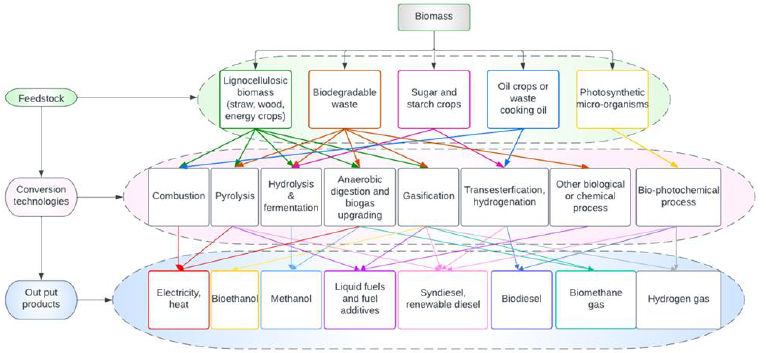
Figure 1. Basic biomass energy feedstocks, conversion technologies, and output products, adopted from [8,16 – 23]. Rice ( Oryza sativa L.) has been a staple food in Sri Lanka since ancient times; the rice consumption per capita was close to 107 kg in 2019, according to the Sri Lanka Rice Re- search Center. The two main seasons for paddy harvesting in Sri Lanka are the Yala season (March to August) and the Maha season (September to December). The main agricultural wastes (by-products) of the rice industry are RH and RS. The rice plant ’ s vegetative part is referred to as rice straw. RS is produced by cutting and removing the plant ’ s grain, which consists of the paddy plant ’ s stem, leaves, and spikes. Rice husk is the rice grain ’ s hard protective covering; it is separated during the milling process. RH is also known as hull and chuff. The quantity and percentage of by-products of paddy processing depend on the type of rice, the geographical area, the growing season, weather conditions, the grinding rate, the market, and many other factors [24 – 28]. RS and RH can be converted into energy using various technologies such as anaero- bic digestion, direct combustion, co-firing, pyrolysis, gasification, etc. [7,8]. Figure A2 shows possible energy generation technologies for RS and RH. Among these technologies, direct combustion and gasification are the most common and are applicable worldwide [29]. In a combustion process, RS and RH are burned in boilers to generate high-pressure steam, which is used to power steam turbine generators [30]. Gasification converts bio- mass into a mixture of gases (CO, H 2 , CO 2, and CH 4 ) called syngas. Gasification is achieved by reacting the feedstock material at high temperatures (>700 °C) and controlling the amount of oxygen and/or steam present in the reaction [31]. Although gasification is char- acterized by having higher efficiencies than combustion processes [32], direct combustion is the most widely used process for biomass conversion; it contributes to over 97% of bio- mass utilization around the world [33]. Using either a combustion or gasification method, there are many technological innovations for energy production such as fluidized bed combustion followed by a steam turbine (FC/ST), gasification with an internal combustion engine (GICE), grate-fired combustion followed by a steam turbine cycle (GFC/ST), and gasification combined cycle system (GCCS). Several reports emphasized that FC/ST has better performance than GFC/ST [10,34,35]. However, FC/ST is associated with higher in- vestment costs [10]. GICE technology requires high-quality raw materials, meticulous op- eration, and has high investment costs; as a result, the technology is commercially availa- ble but not widely used [36]. GCCS is a highly efficient technology, but it is in early stage of development. On the other hand, GFC/ST is an economic technology, can operate a